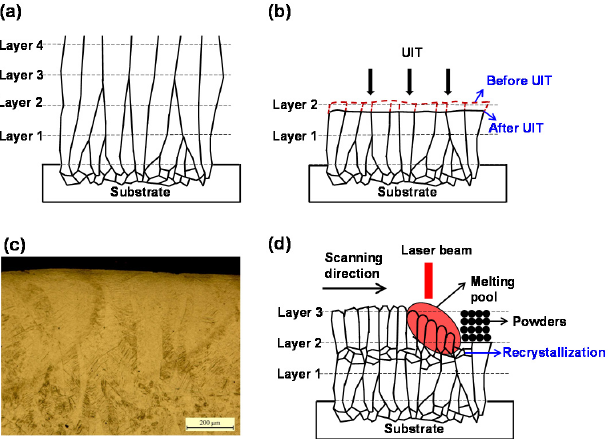
Figure 6. ( a ) Schematic view of epitaxial growth of columnar grains during SLM; ( b ) Schematic view of compressive plastic deformation introduced by UIT; ( c ) OM image showing the grain morphology in the last layer of UIT assisted SLM sample with 0.6 mm hatch spacing, which has been treated by UIT; ( d ) Schematic view of the formation of equiaxed grains due to recrystallization during laser